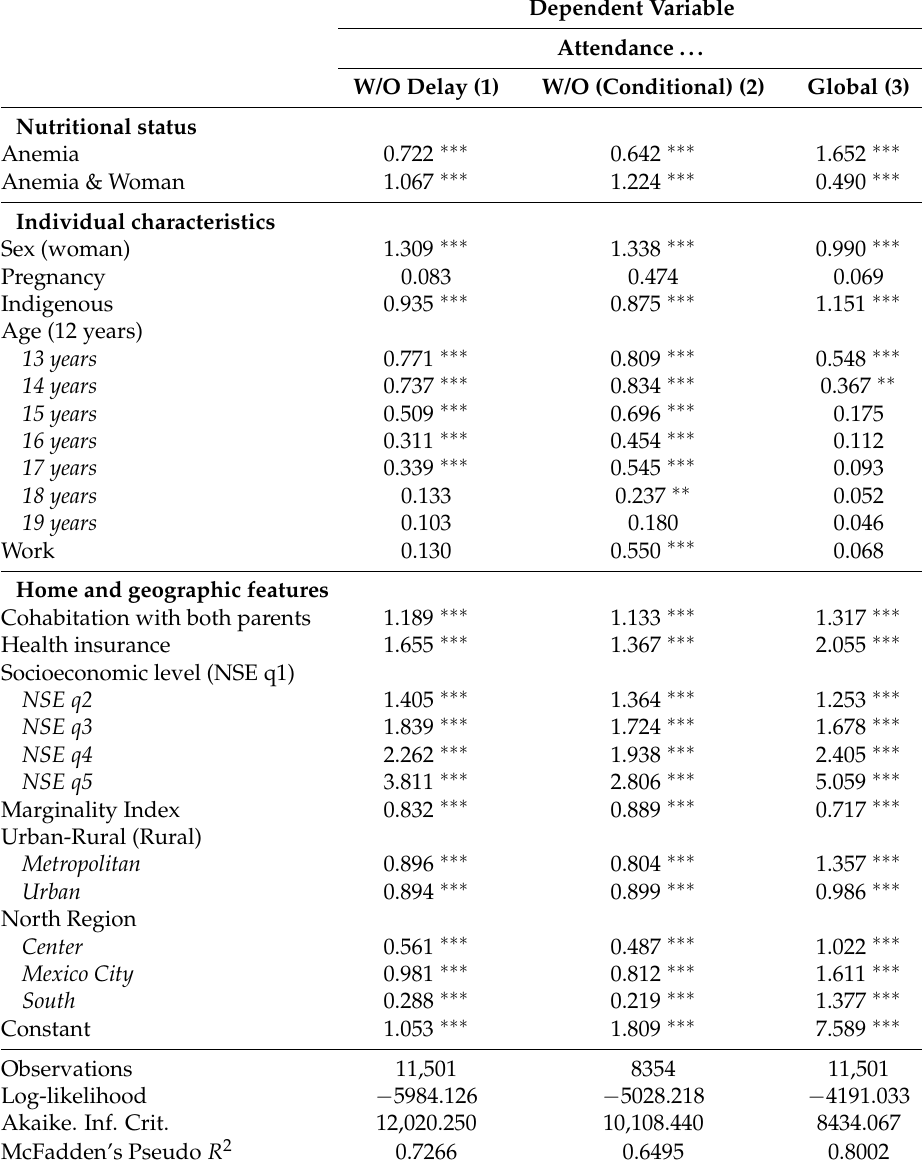
Table A5. Estimation of the odds ratio, men and women. Dependent